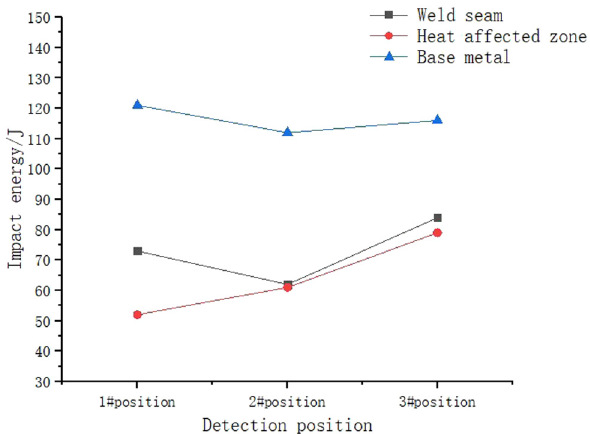
Figure 6: 1 – 3# Impact energy of weld seam and heat a ff ected zone of welded joint section.